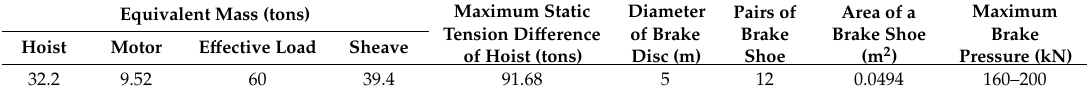
Table 1. JKMD-5 × 4(III)-type floor multi-rope friction hoisting system in Guqiao coal mine in China.